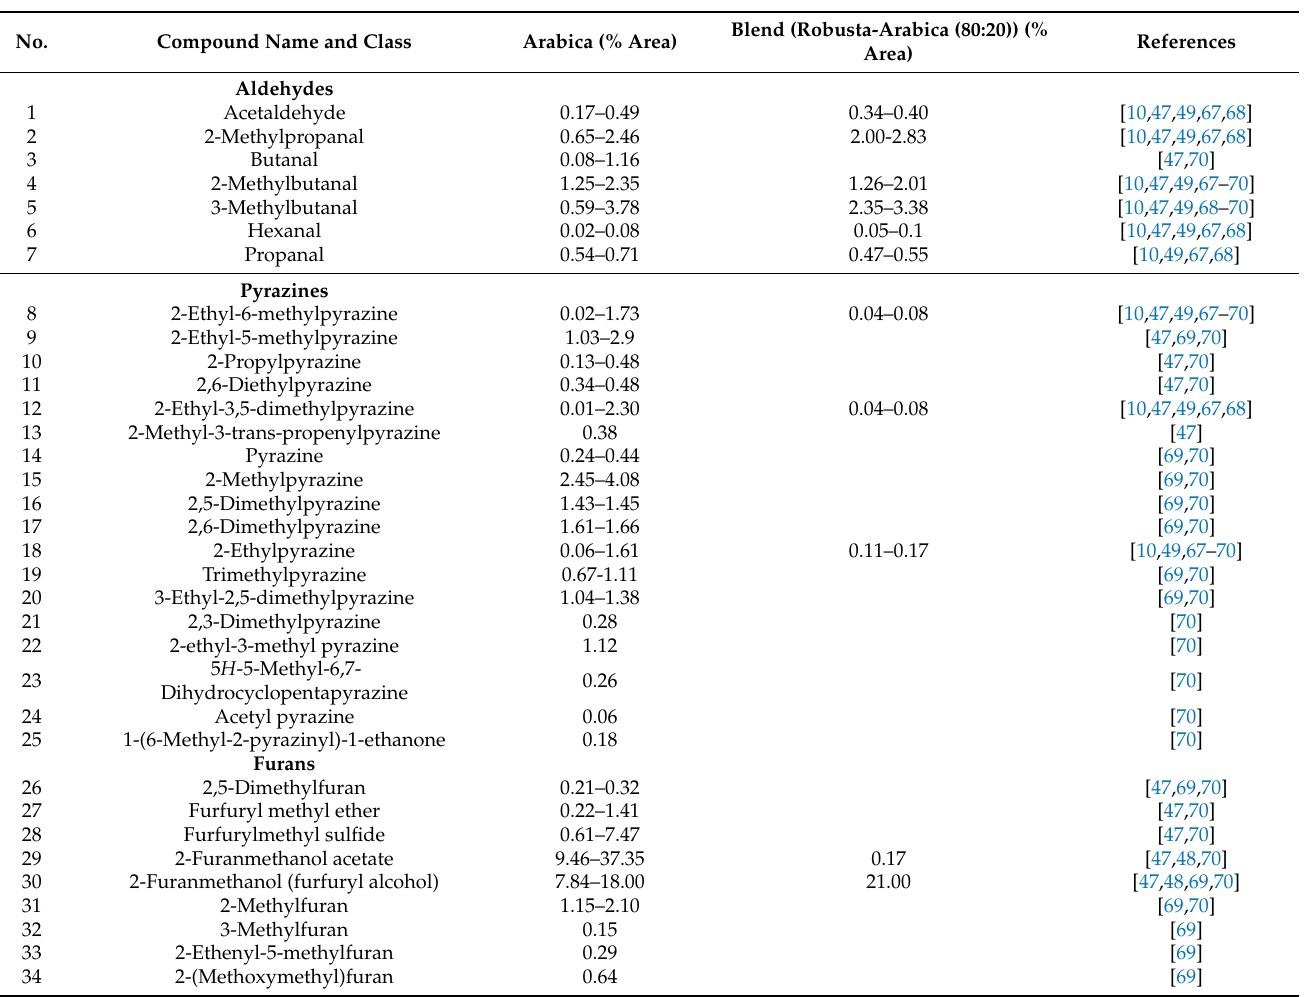
Table 1. Volatile organic compounds (VOCs) identified in different varieties of EC and their relative percentages of the area (% area) according to the